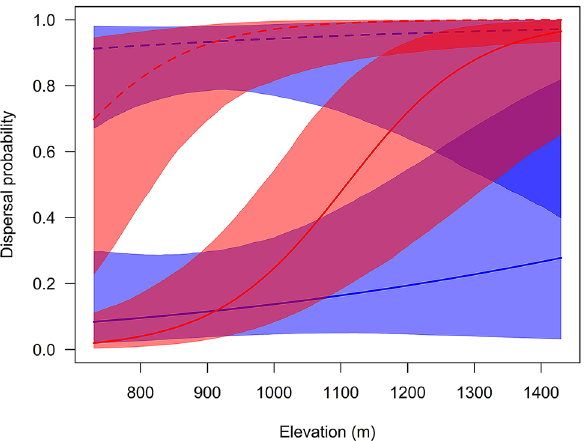
Figure 2. Model estimates of dispersal probabilities in relation to elevation for females (red), males (blue), adults (solid lines), and juveniles (broken lines). The shadowed areas indicate 95% credible intervals. N = 126 recaptures of 89 individuals.